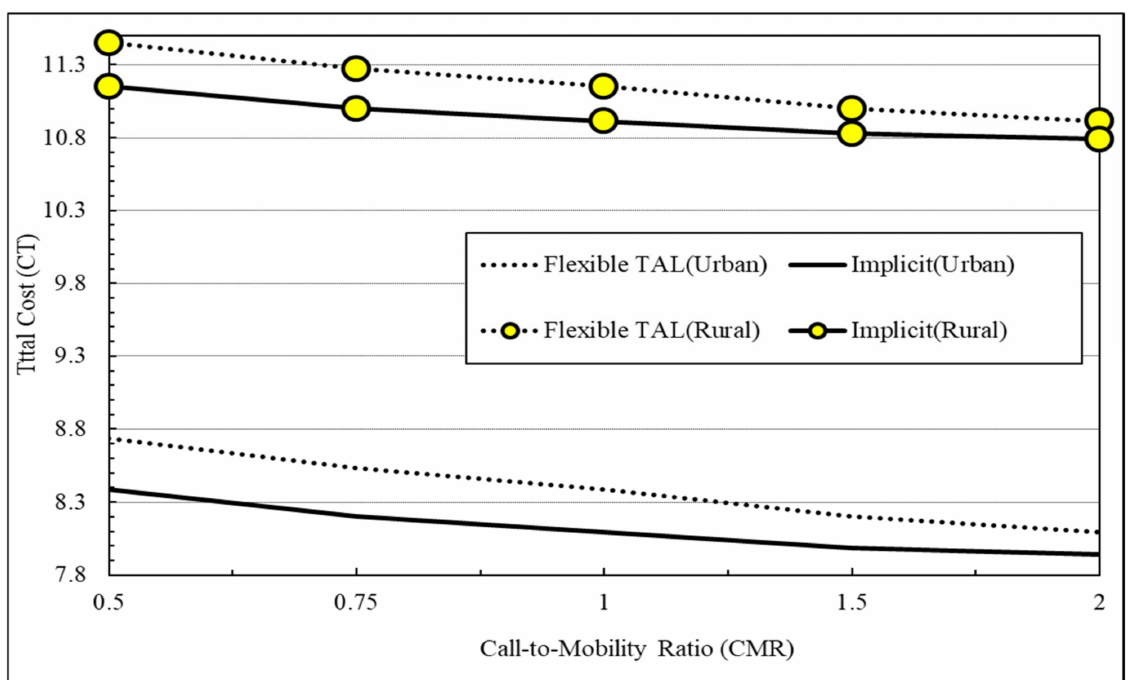
Figure 8. Performance improvement of implicit